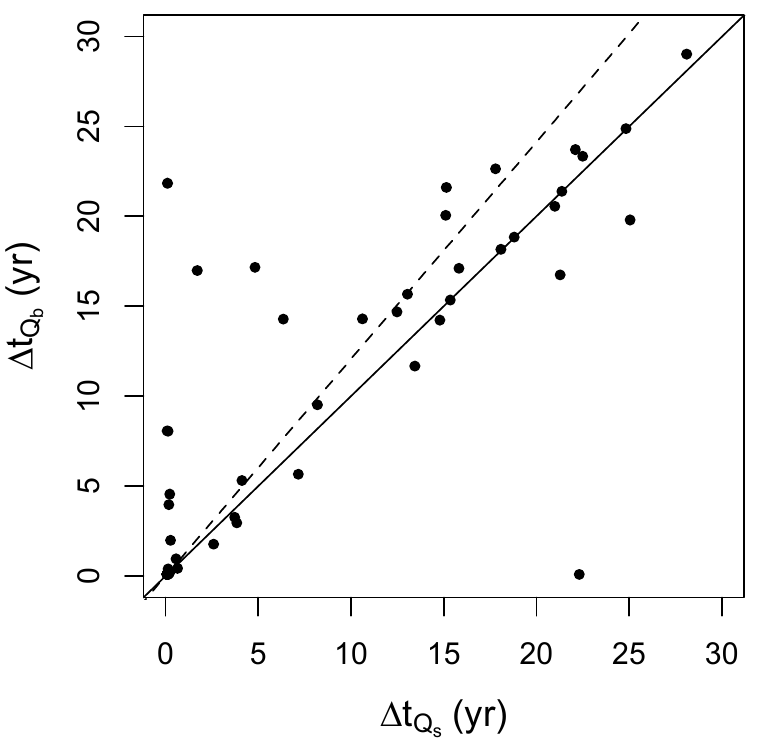
Figure 4. Mean ∆𝑡 between recharge ( 𝑅 ) and baseflow ( 𝑄 (cid:3029) ) plotted against mean ∆𝑡 between 𝑅 Figure 4. Mean ∆ t between recharge ( R ) and baseflow ( Q b ) plotted against mean ∆ t between R and and streamflow ( 𝑄 (cid:3046) ). Points above the solid line indicate ∆𝑡 (cid:3018) streamflow ( Q s ). Points above the solid line indicate ∆ t Q the best ‐ fit linear regression with a slope of 1.2, 𝑅 (cid:2870) (cid:3404) 0.81 (note that there are 19 points between (0, best-fit linear regression with a slope of 1.2, R 2 = 0.81 (note that there are 19 points between (0, 0) 0) and (1, 1)). and (1,